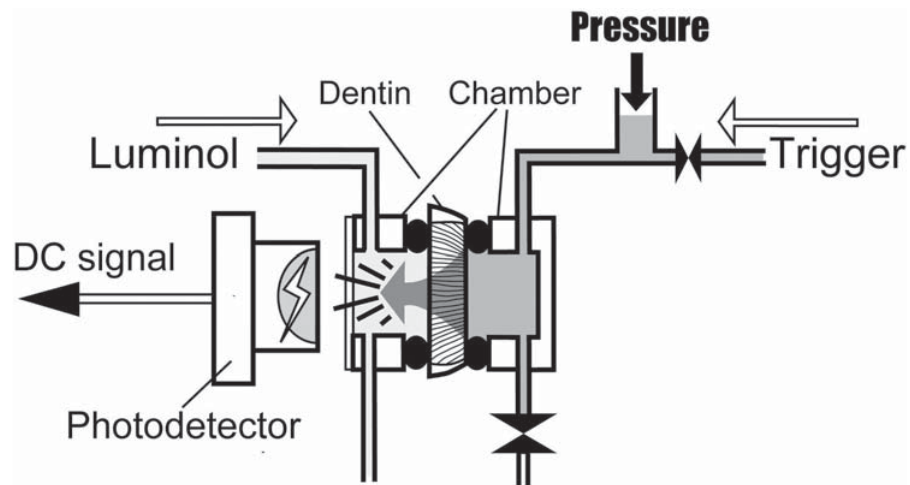
Figure 1- Measuring device for determination of dentin permeability. The activator solution (trigger) is enclosed in the chamber on the pulpal side of the specimen. Upon start of measurement, the trigger is pressurized to 2.5 and 13 kPa respectively, while the luminol remains at atmospheric pressure. The trigger penetrates through the dentin specimen, and a photochemical reaction is generated upon contact with the luminol. Light emission is detected with a photodetector through a window of the chamber on the occlusal side and outputted as DC